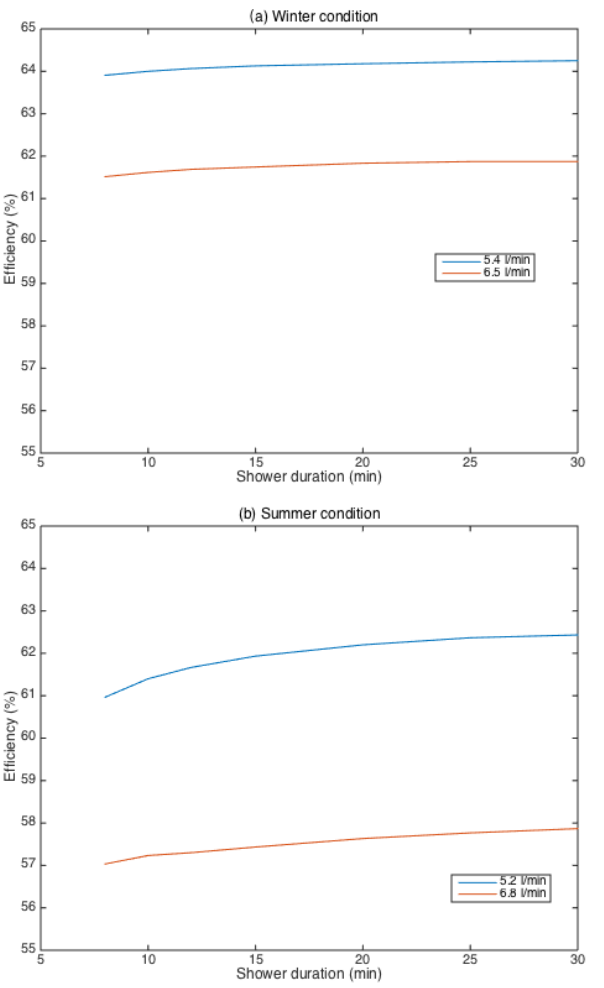
Figure 5. Energy recovery efficiencies versus impact parameters.